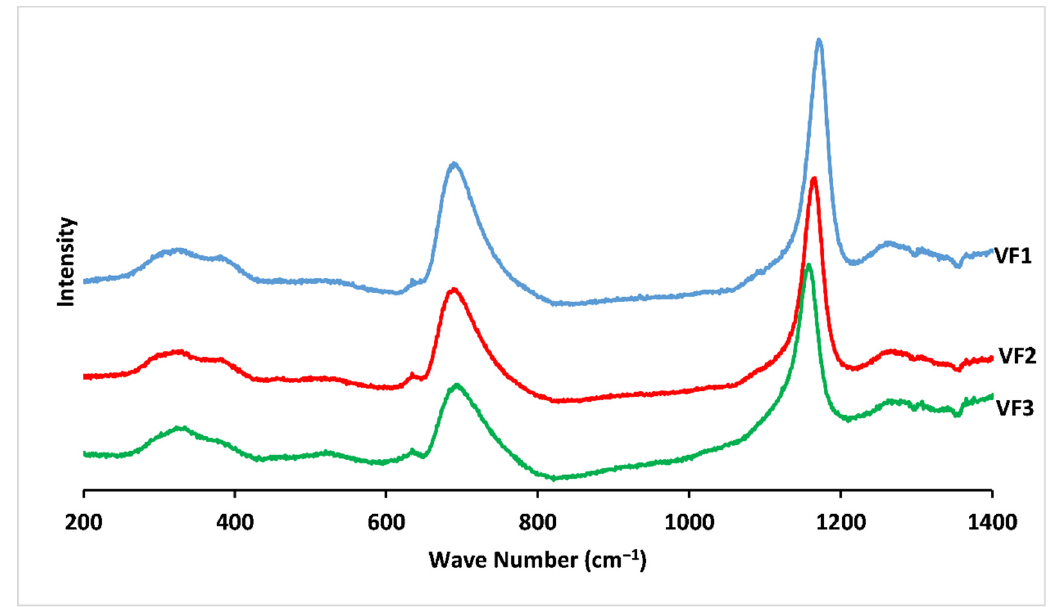
Figure 3. Raman spectra for concentrations of [K 2 O/(CaO+MgO)] ratio (%mol). VF1: 0.67 %mol, VF2: 1.33 %mol and VF3: 2 %mol.